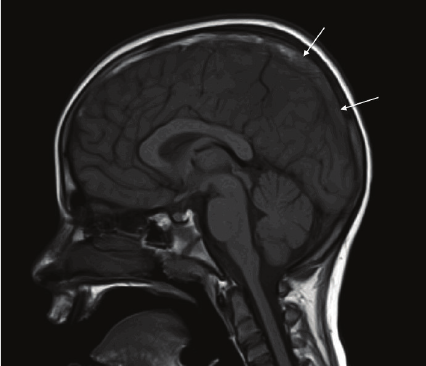
Figure 1: Plain CT scan demonstrated 10mm × 15mm right frontal intracerebral hemorrhage (arrow).